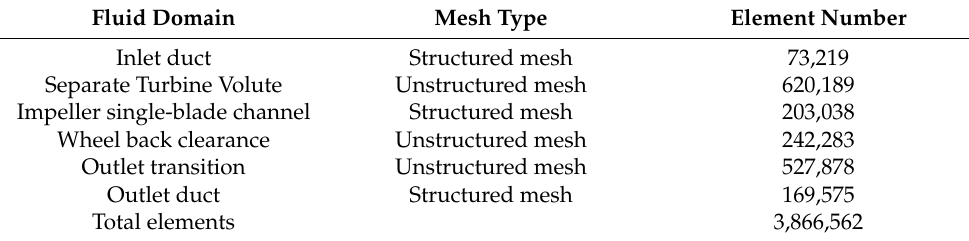
Table 4. The elements for the turbine